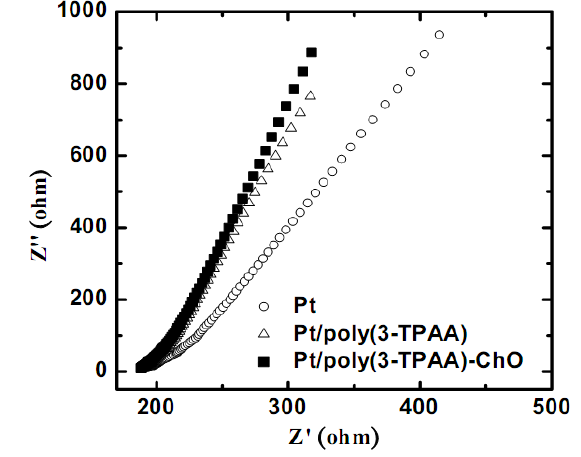
Figure 5. The electrochemical impedance spectroscopy data for the Pt, Pt/poly(3-TPAA) and Pt/poly(3-TPAA)-ChO electrodes in 0.1 M PBS with 1.0 mM Fe(CN) 63- .